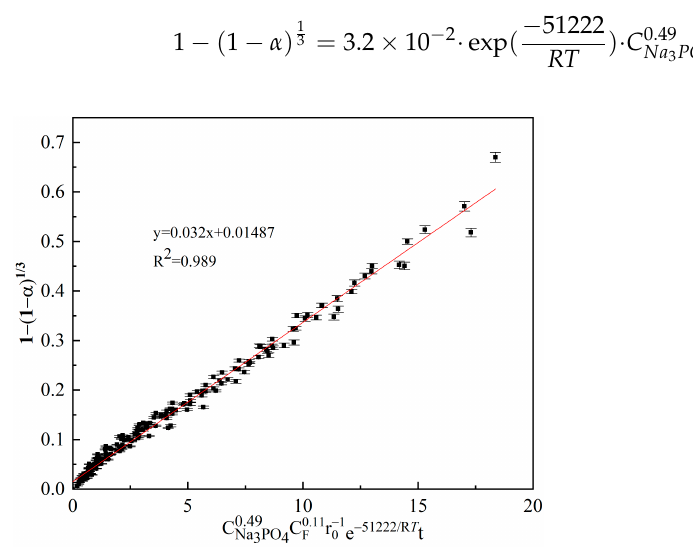
− 1 · t ) · C 0.49 · C 0.11 · r 0 F RT Na 3 PO 4